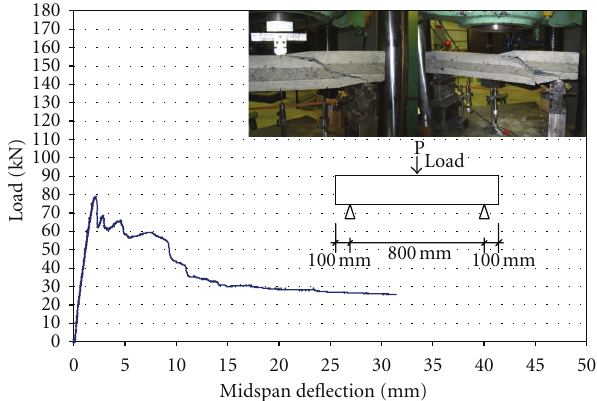
Figure 5: Load versus midspan deflection of control RC beam C-S-2.